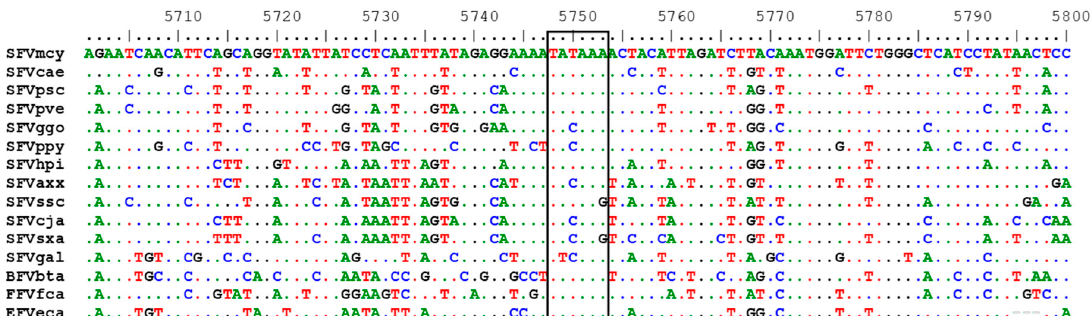
Figure 2. Conserved TATA box in alignment of foamy virus polymerase sequences. Dots represent conserved nucleotides relative to the first sequence. Nucleotide positions are after alignment using MAFFT. Old World apes (OWA): SFVpve, Pan troglodytes verus (chimpanzee), GenBank accession number U04327; SFVpsc, Pan troglodytes schweinfurthii (chimpanzee), Y07725; SFVppy, Pongo